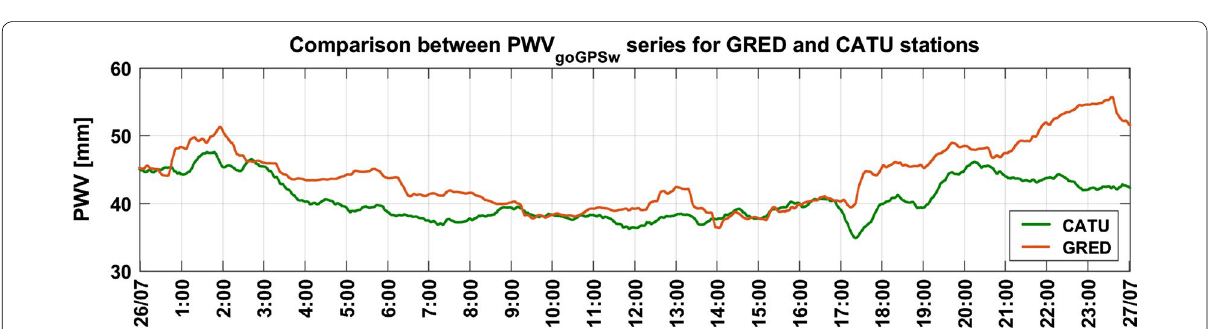
Fig. 12 July 26, 2016, event PWV goGPSw values for CATU and GRED